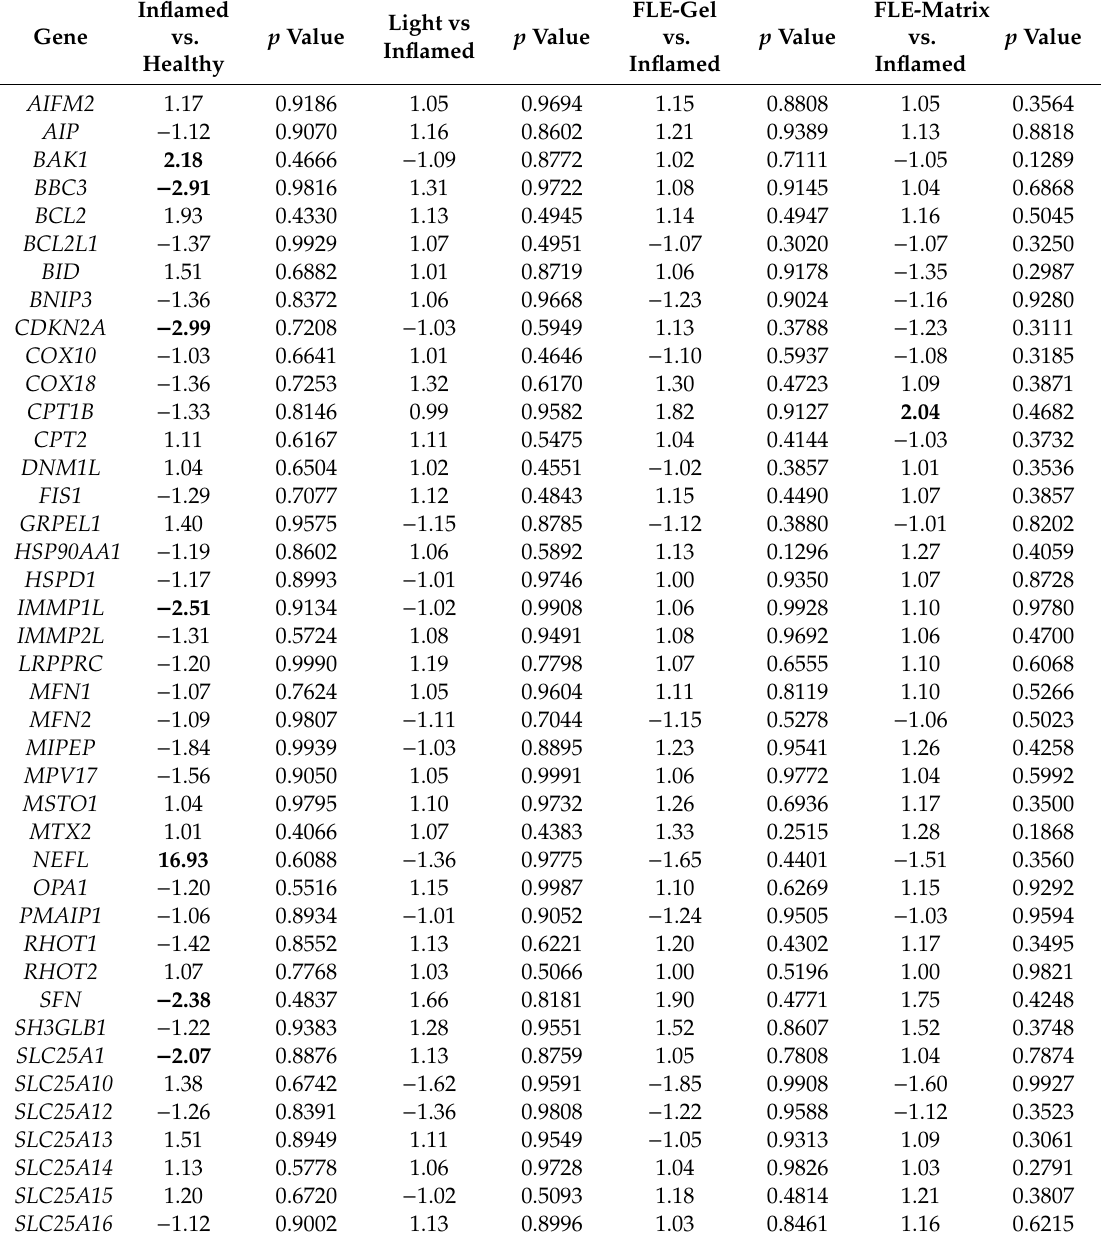
Table 2. Human Mitochondria PCR